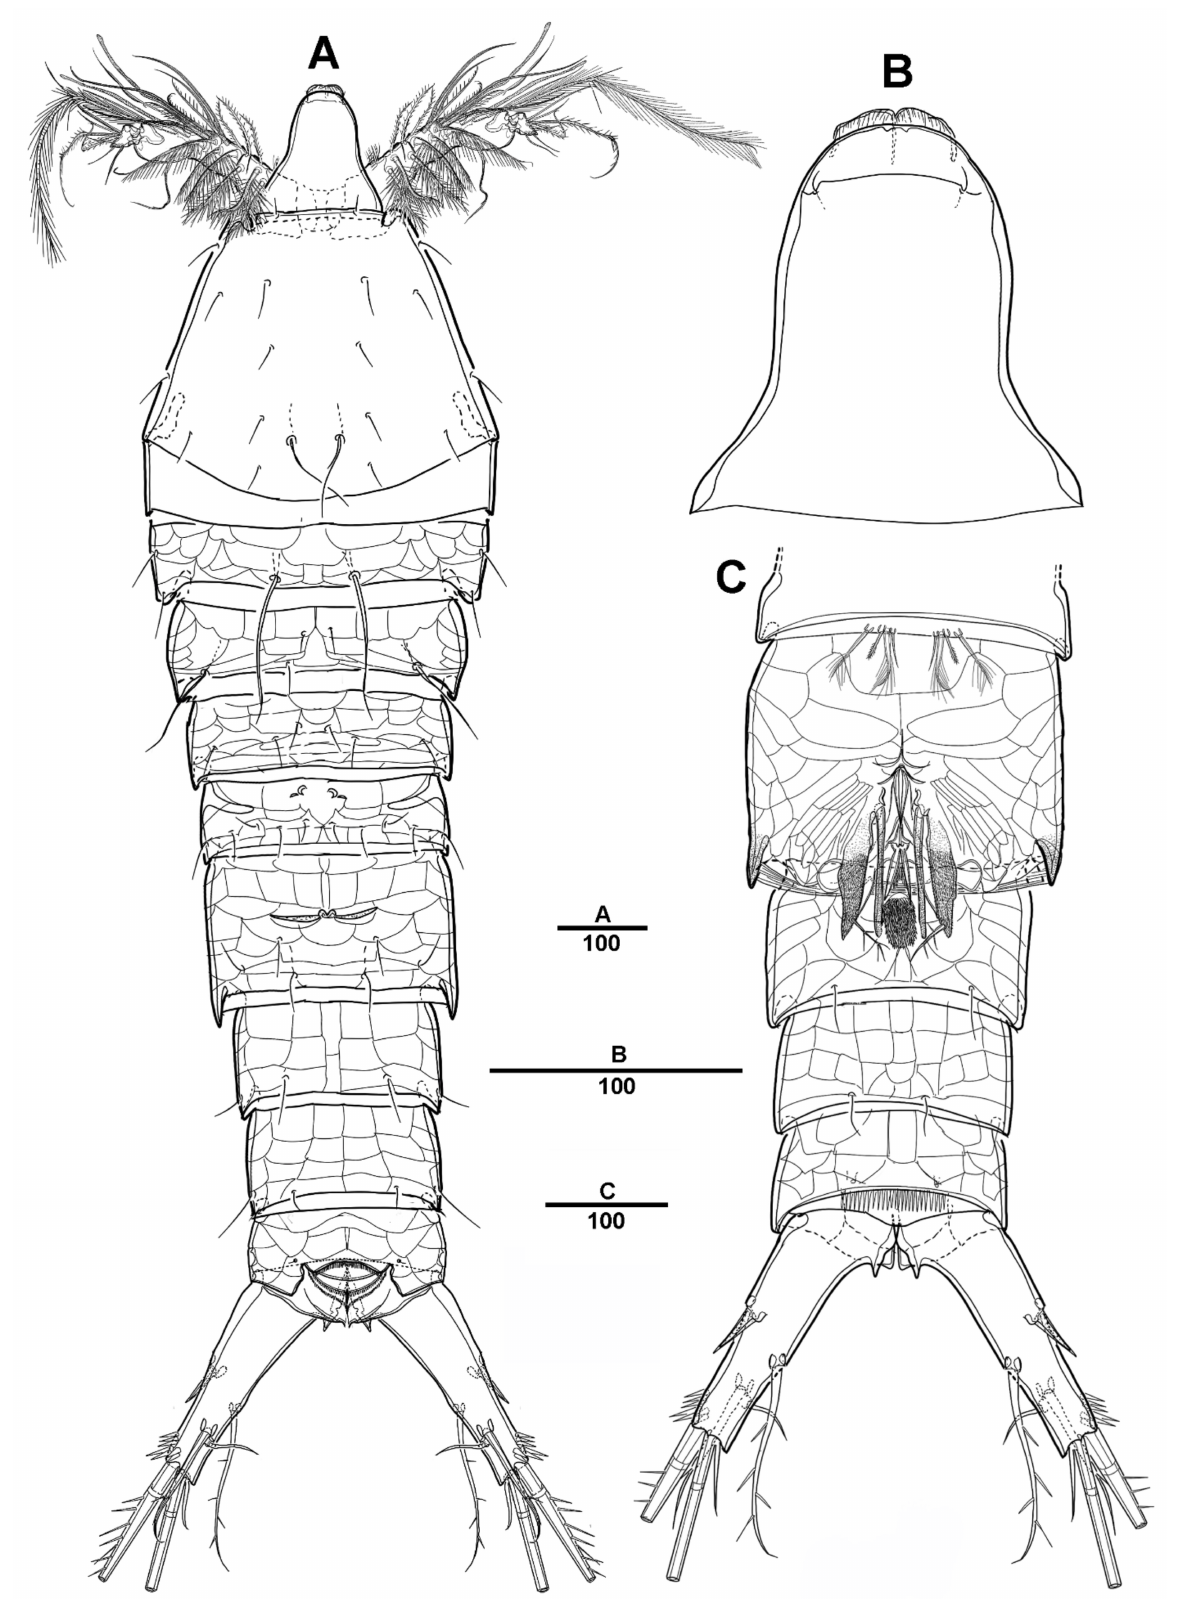
Figure 19. Scottolana wonchoeli sp. nov. paratype male: ( A ) habitus, dorsal; ( B ) rostrum, dorsal; ( C ) urosome, ventral. Scale bars in µ